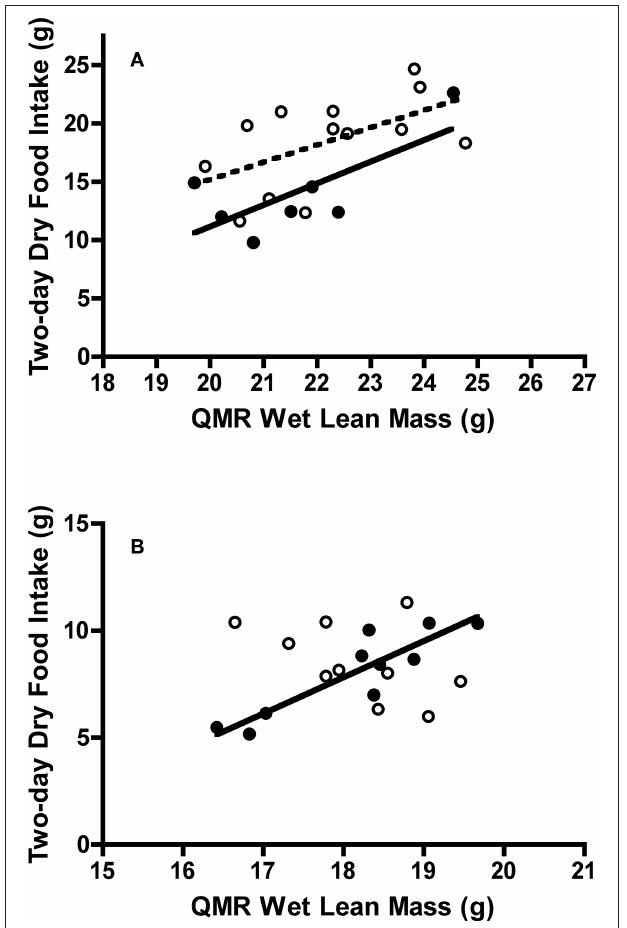
FIGURE 6 | Effect of QMR wet lean mass on dry food intake of adult and juvenile (A) Swainson’s thrushes and (B) white-throated sparrows during a 2-day total collection mass balance feeding trial. All birds captured at Long Point, ON, Canada during fall 2011 migration stopover. Filled circles and solid lines represent adults: thrushes dry food intake = − 25.95 ( ± 17.09) + 1.855 ( ± 0.790) * QMR wet lean mass, r 2 = 0.53; sparrows dry food intake = − 22.74 ( ± 5.39) + 1.698 ( ± 0.297) * QMR wet lean mass, r 2 = 0.80. Unfilled circles and dashed lines represent juveniles: thrushes dry food intake = − 14.54